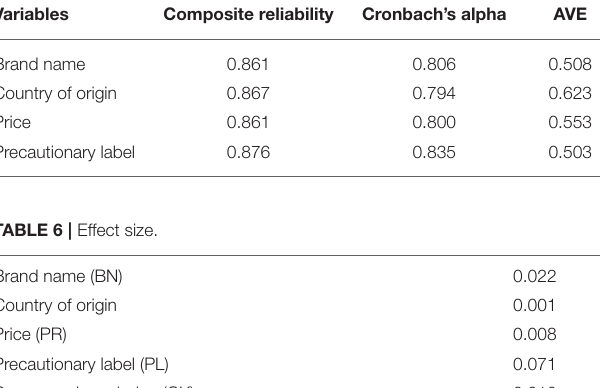
TABLE 5 | AVE and composite reliability.